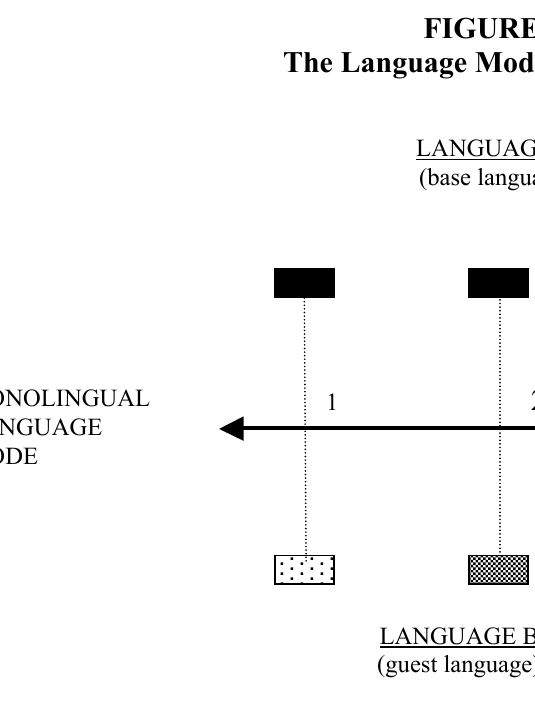
(The degree of shading represents activation level, and solid black indicates total